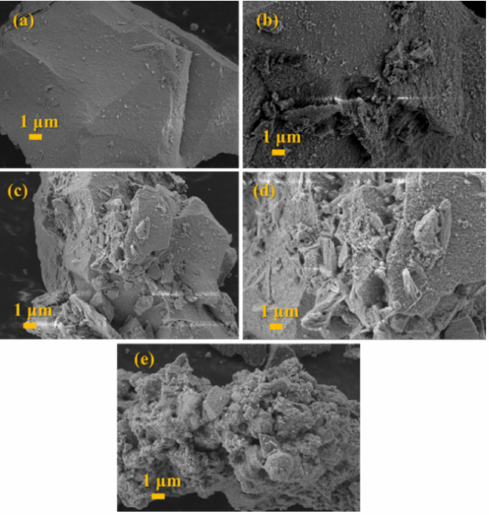
Figure 4. SEM images of CuCeO x /Fe 2 O 3 ( a ), CuCeO x -3K/Fe 2 O 3 ( b ), CuCeO x -5K/Fe 2 O 3 ( c ),